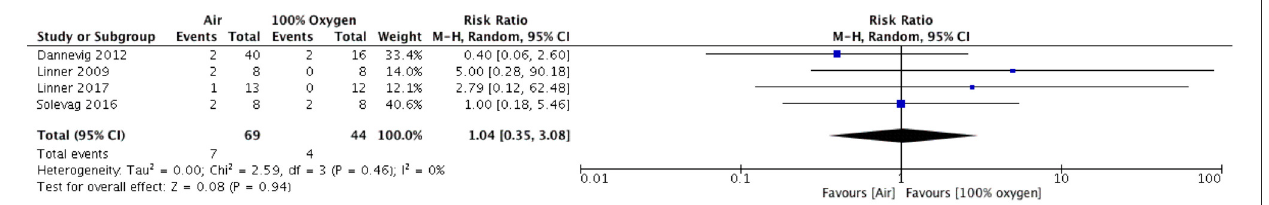
FIGURE 1 | Mortality in piglets resuscitated with either Air or 100% oxygen during neonatal cardio-pulmonary resuscitation. O 2 while an additional study compared 3:1 C:V vs. continuous CC with asynchronous ventilation (CCaV) in addition to air